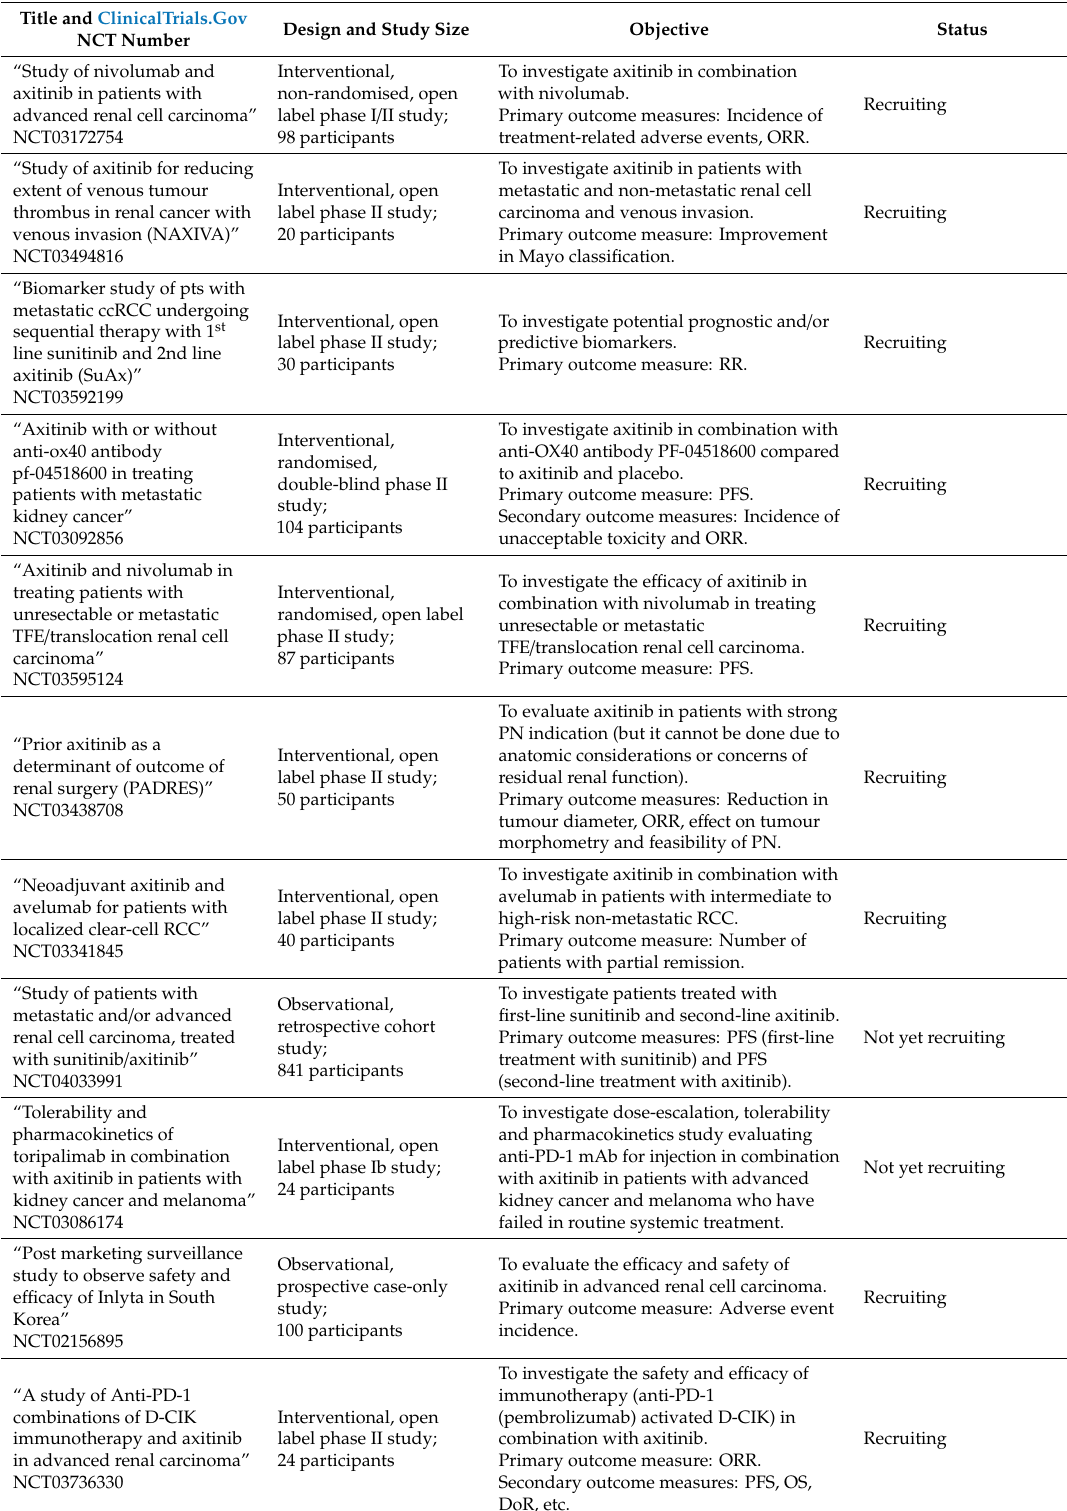
Table 8. Currently active clinical trials for the use of axitinib in renal cell carcinoma therapy